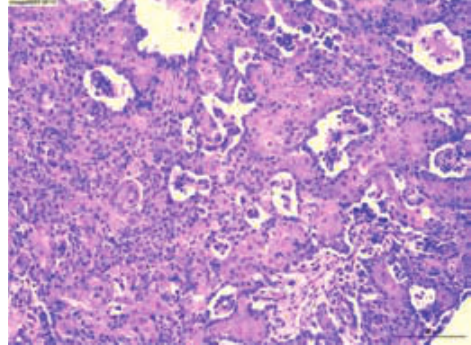
Fig. 6. Hepatoid gland carcinoma- invading neoplastic cells (arrow) into the blue stained connective tissue stroma (Masson’s trichrome x